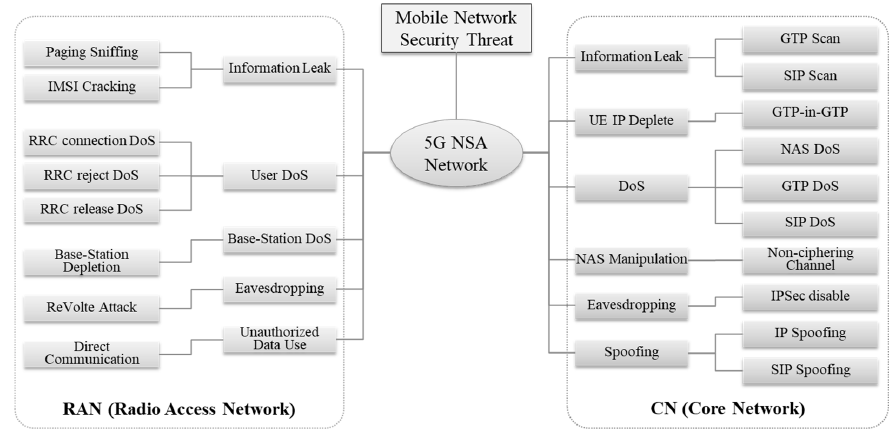
Figure 7. 5G NSA attack